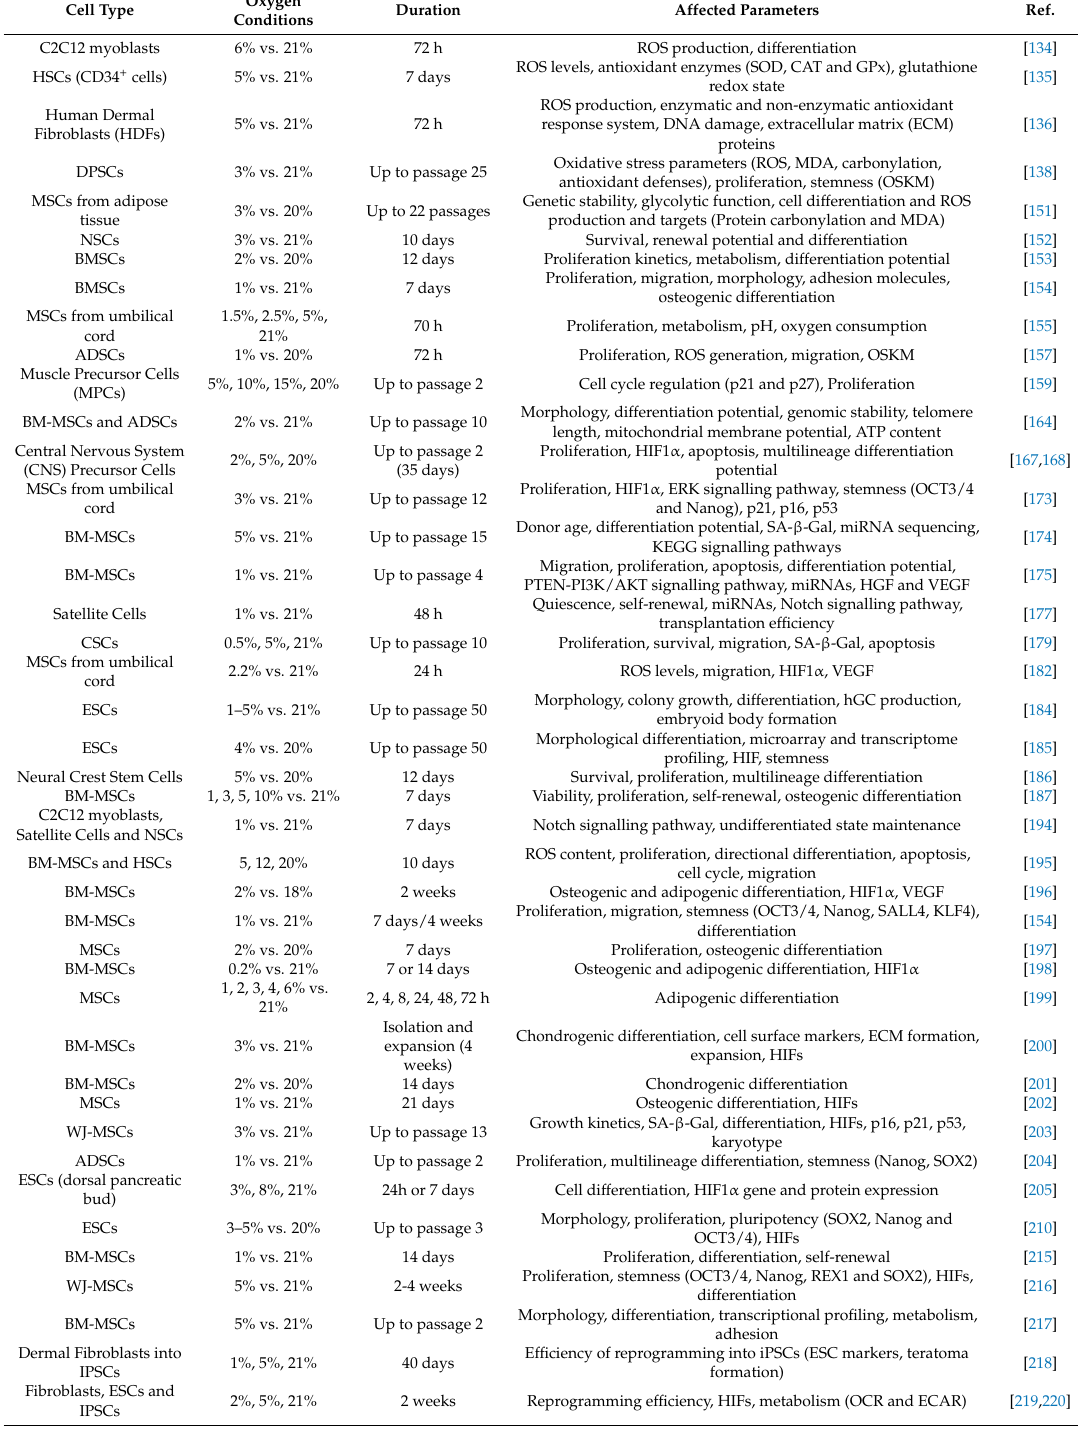
Table 1. Summary of relevant studies on stem cells alterations at different oxygen